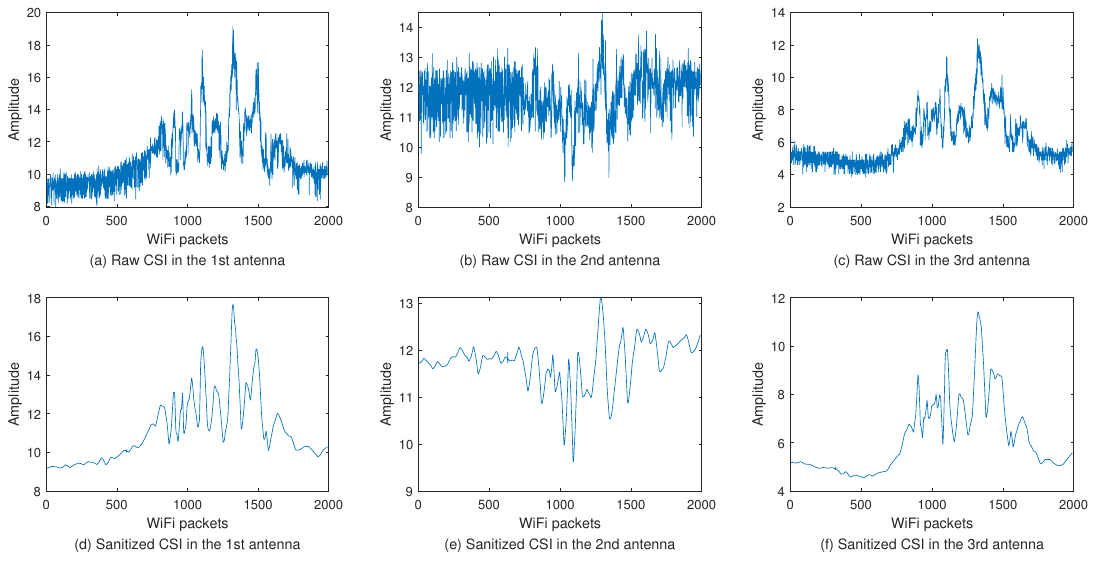
Figure 3. Raw CSI and sanitized CSI of the first subcarrier in each antenna. ( a – c ) are the CSI amplitudes obtained by collecting the same gesture signal by the three antennas of the WiFi device. ( d – f ) are their sanitized CSI